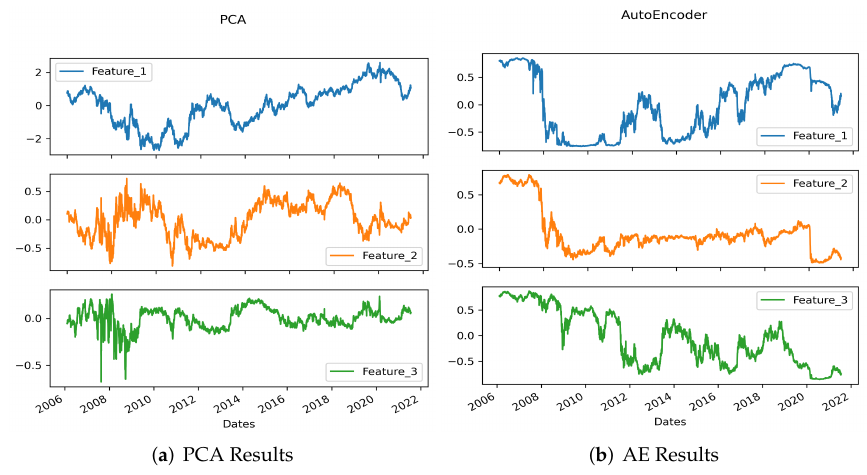
Figure 15. Comparison of the results of PCA and AE for the US data.